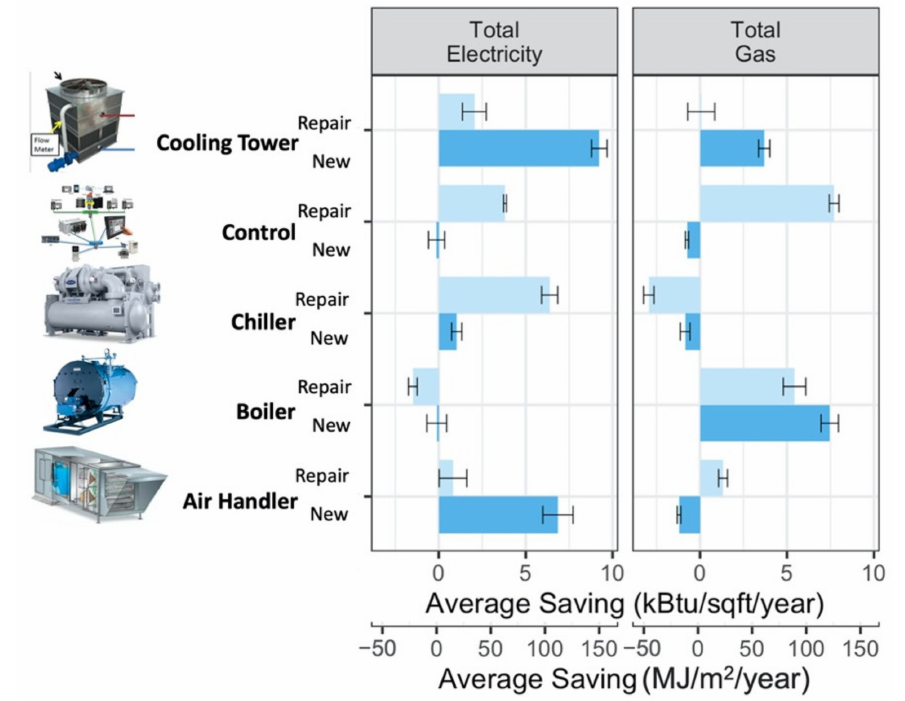
Figure 8. Bar chart of the mean and 95% C.I. of the estimated retrofit effects of past HVAC retrofit sub-actions on the site electricity EUI and site gas